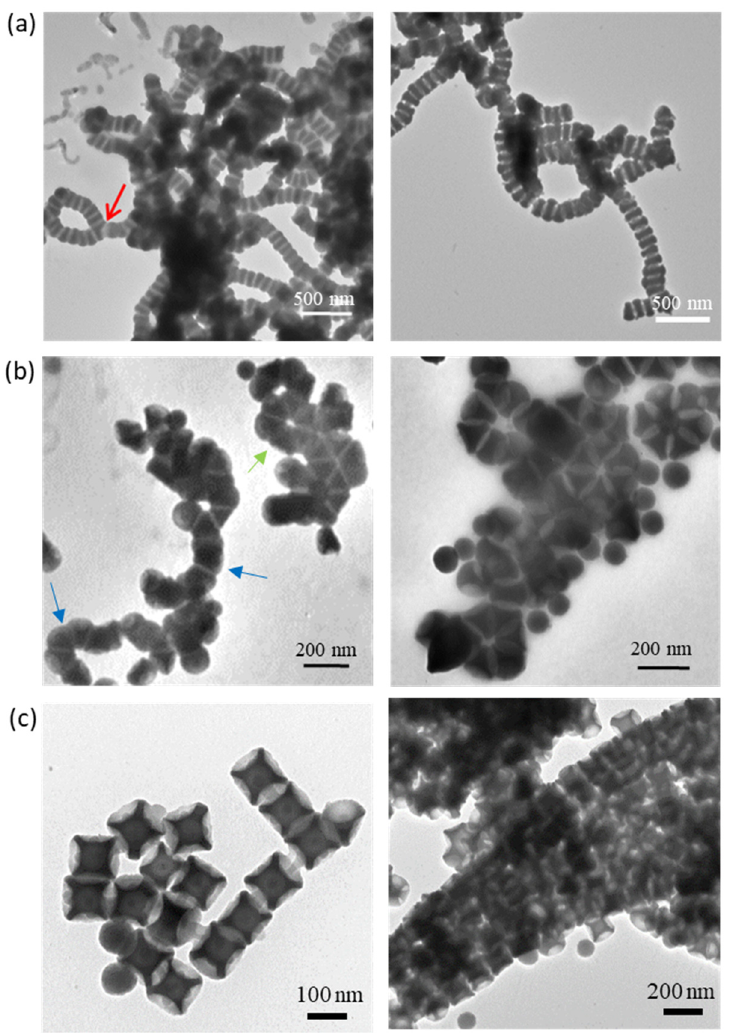
Figure 2. ( a ) TEM images of colloidal chains obtained after incubating two-patch silica nanoparticles for 19 h into a 7/3 ( v/v ) THF/salty water mixture. ( b ) TEM images of chains and hexagonal super- structures obtained after incubating three-patch silica nanoparticles for 16 (left) and 40 (right) hours into a 9/1 ( v/v ) THF/water mixture. ( c ) TEM images of assemblies resulting from the incubation of six-patch nanoparticles for 16 (left) and 40 (right) hours into a 9/1 ( v/v ) THF/water mixture.